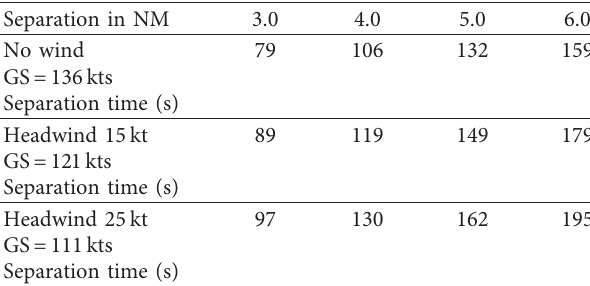
Table 12: Effect of headwind on time separation [29].